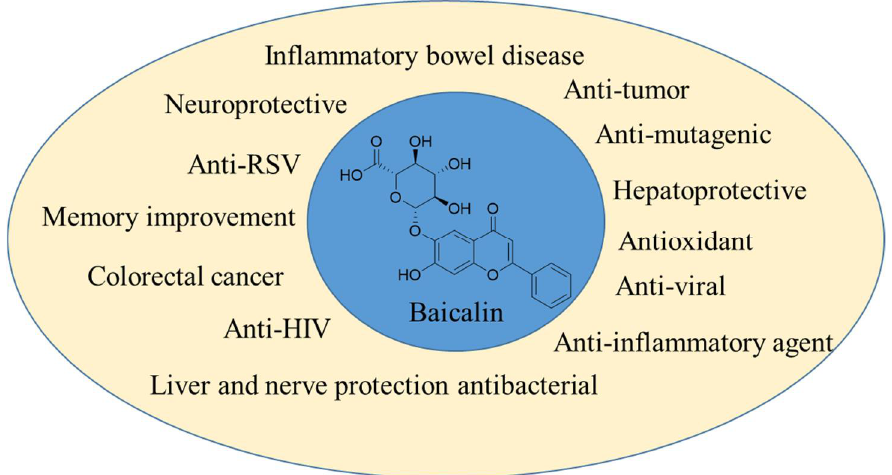
Figure 5. Therapeutic applications of baicalin.